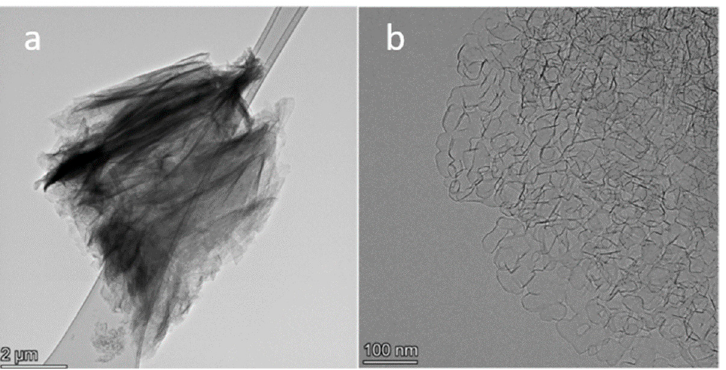
Figure 1. TEM images of N-graphene at different magnifications: particle agglomerates ( a ) and surface morphology ( b